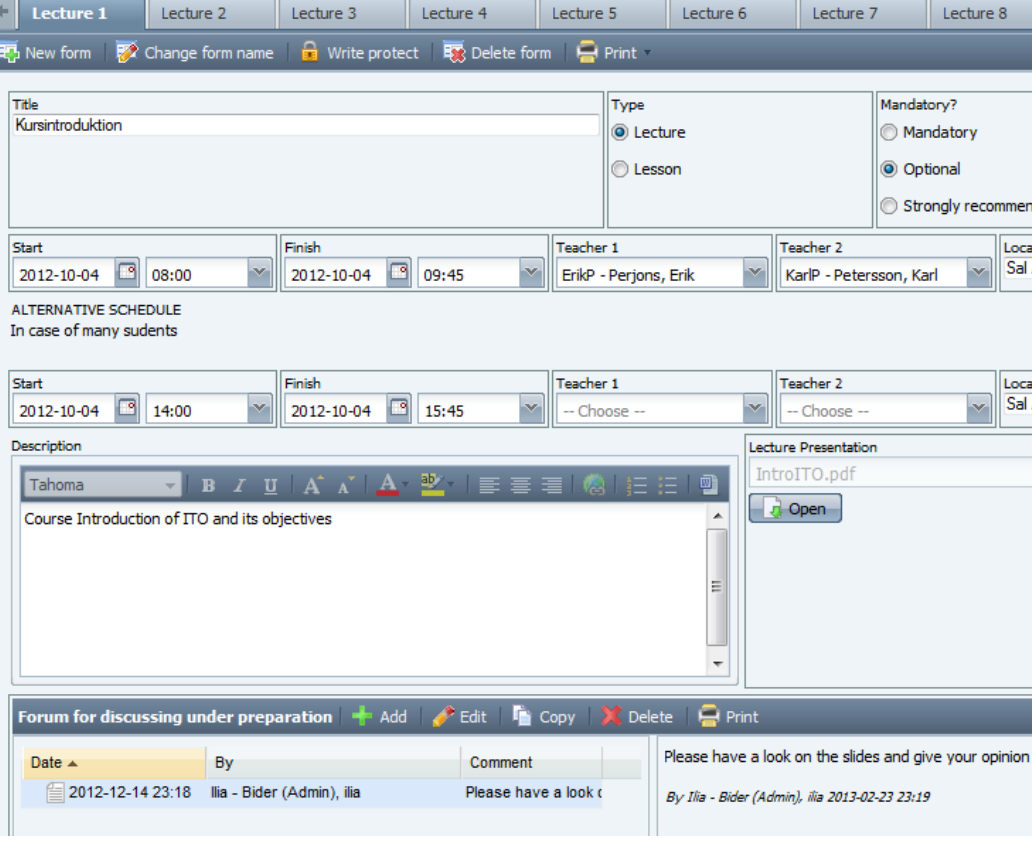
Figure A4. Step form from Figure A3 as a